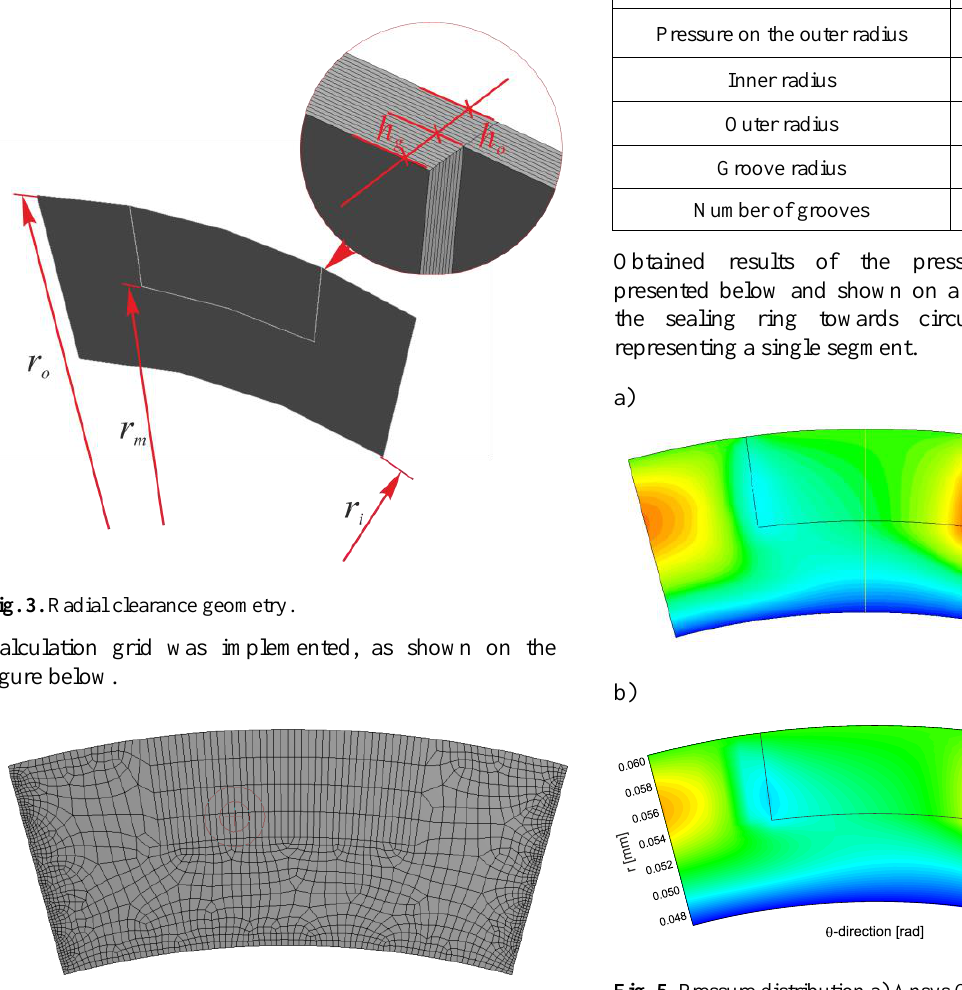
Fig. 5. Pressure distribution a) Ansys CFX, b) author ’ s C++ language computer